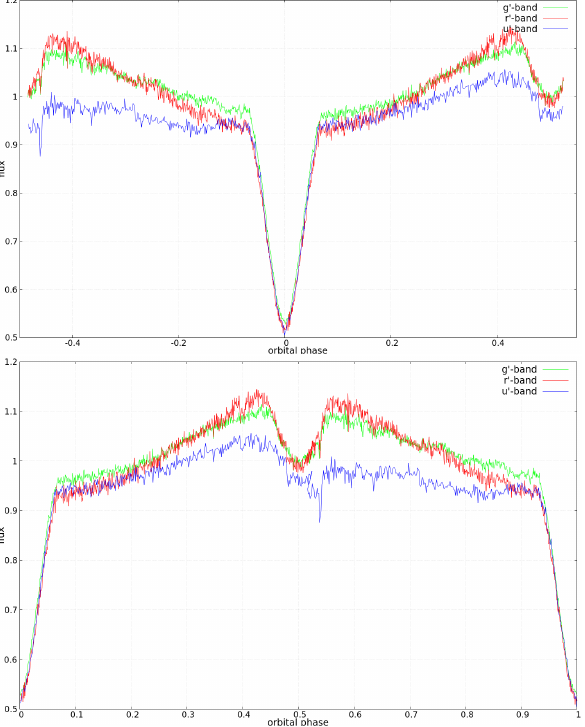
Figure 6. Top: Original ULTRACAM light curves; bottom: Light curves adapted for MORO. The second minimum lays now at Φ = 0.5, the blue light curve is obviously not usable for further analysis.